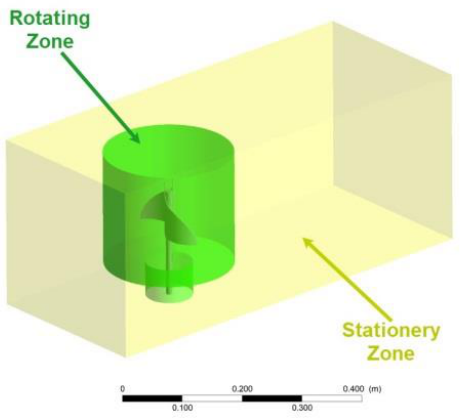
Figure 10. Two different zones of the IceWind turbine’s domain: rotating and stationary zones. Figure 10. Two di ff erent zones of the IceWind turbine’s domain: rotating and stationary zones.